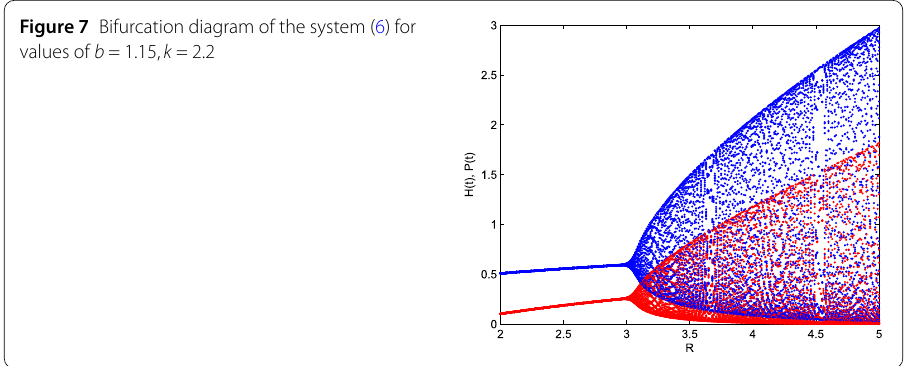
Figure 7 Bifurcation diagram of the system (6) for values of b = 1.15, k = 2.2